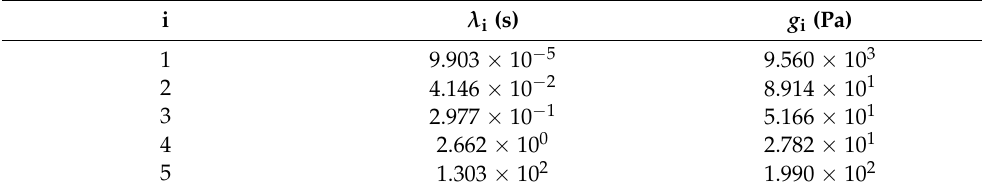
Figure 1. The linear viscoelastic property of the cross-linked waxy corn starch dispersion at 20 °C, which is mixed with 300 g/kg sucrose and heated to 85 °C in the Rotavapor. The symbols are the experiments in Figure 7a of Acquarone and Rao [18], and the lines are the fits here. Table 2. The relaxation spectrum of the cross-linked waxy corn starch dispersion with 300 g/kg sucrose at 20 ◦ C, which is heated to 85 ◦